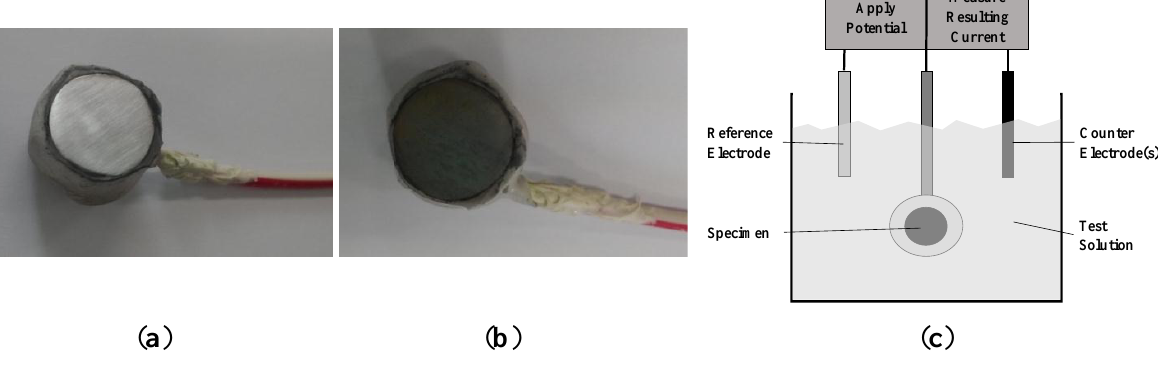
Figure 2. Reinforcing steel specimen and schematic diagram of the test rig. ( a ) Specimen (Before); ( b ) Specimen (After); ( c ) Schematic diagram of the potentiostat.